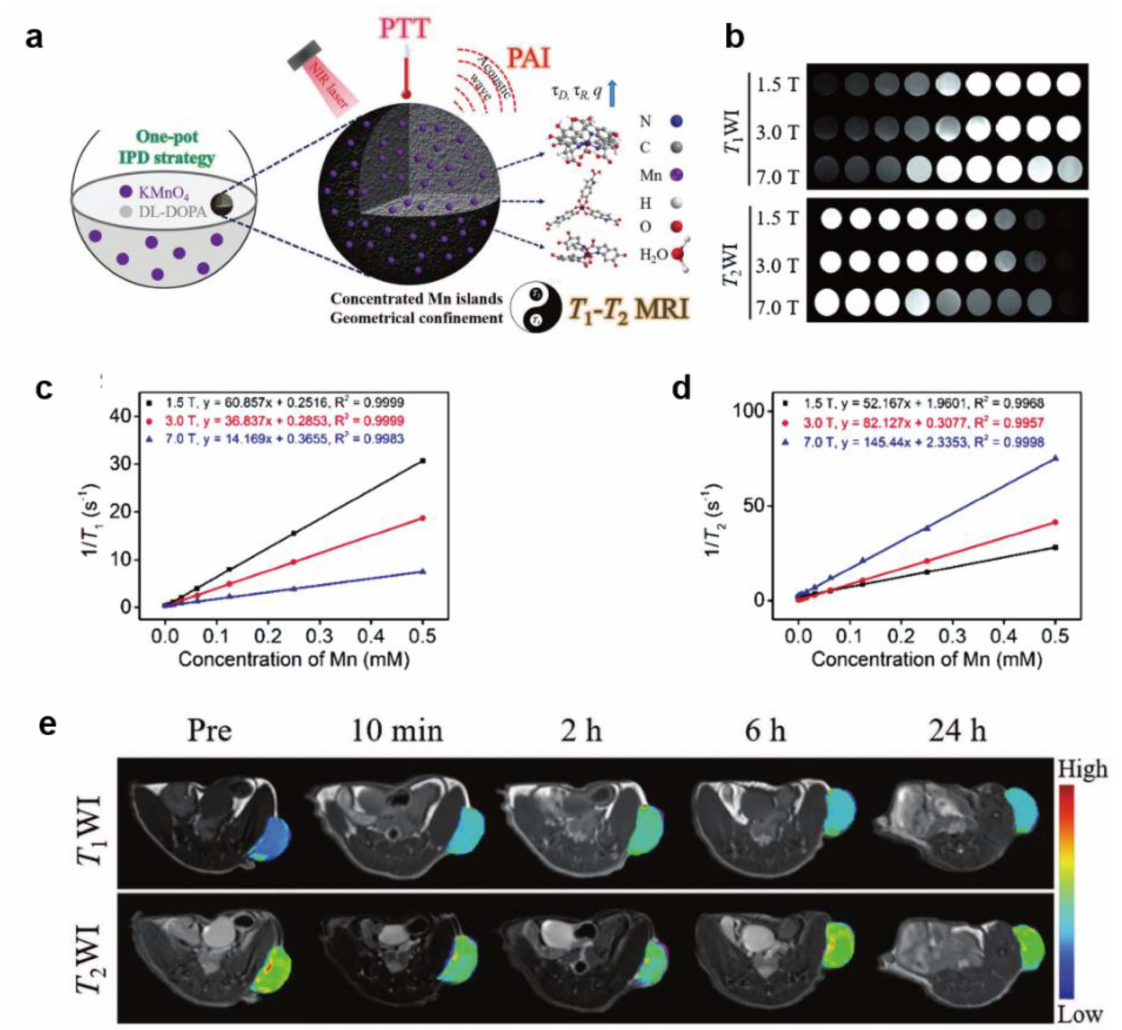
Figure 6. Manganese doped melanin-like nanoparticles for dual-model MRI in vitro and vivo. ( a ) Synthesis procedure and theranostic applications of Mn 2+ -melanin-like NPs. ( b ) T 1 WI and T 2 WI at various magnetic fields (MFs). The linear relationship for the ( c ) r 1 and ( d ) r 2 relaxivities of MnEMNPs as a function of Mn 2+ concentration at various MFs. ( e ) In vivo theranostic evaluation of U87MG tumor as a function of time after injection with MnEMNPs